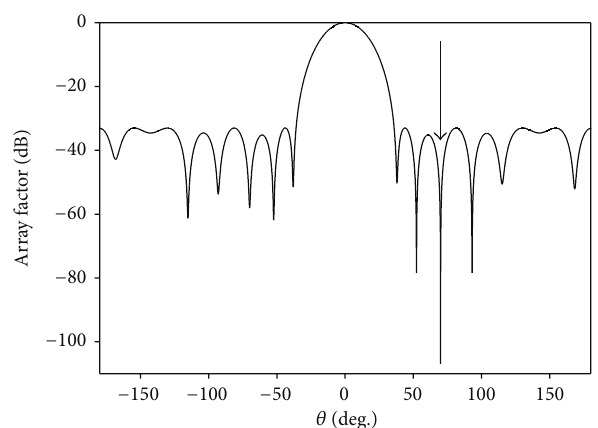
Figure 18: Radiation pattern obtained by amplitude-only control with one imposed null at 70 ∘ .